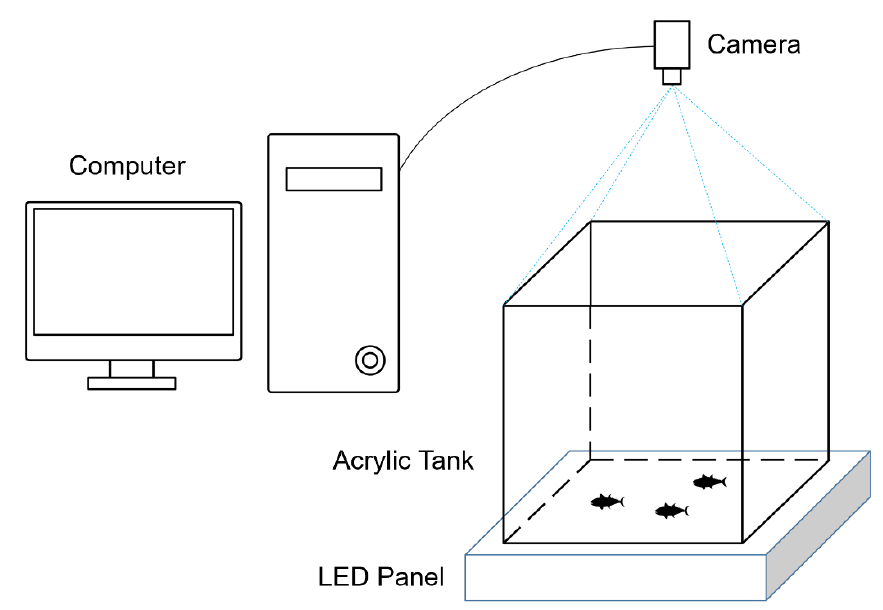
Figure 7. Observation system setup.